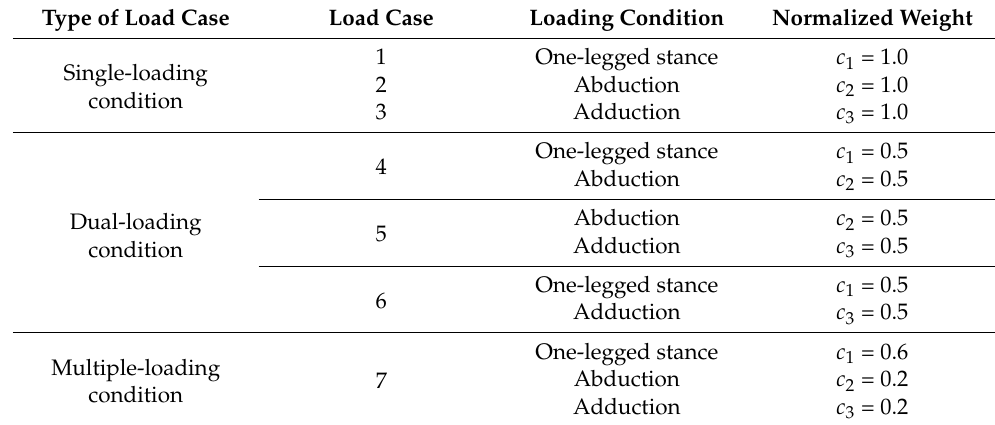
Table 1. Loading conditions for proximal femur structural behavior